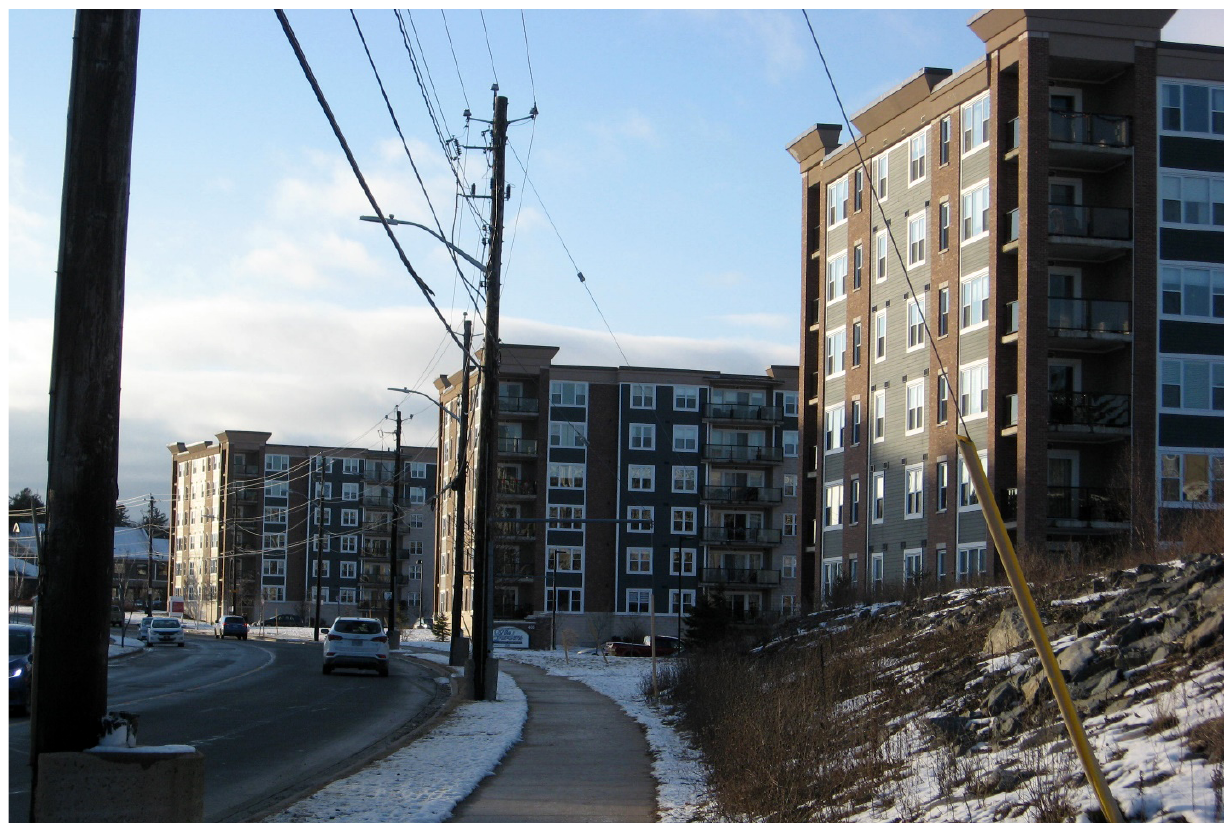
Figure 1. Halifax, Nova Scotia, Canada: The plan called for new urbanism principles to increase suburban densities, but the results are repetitious. Source: Photo by